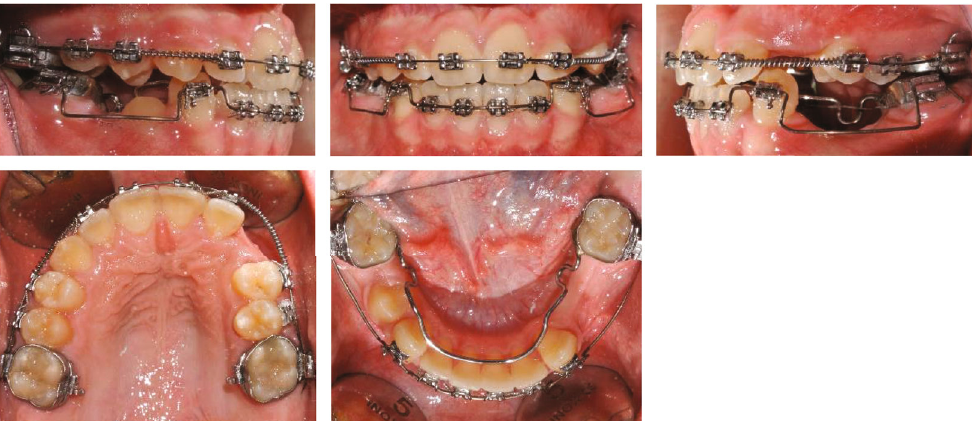
Figure 6: Case no. 1 fi xed appliance phase.